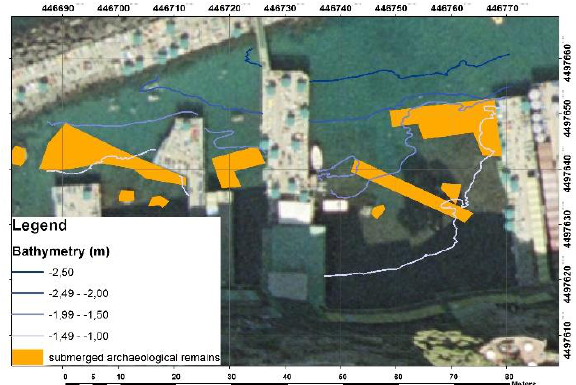
Figure 11. Bathymetric map of the study area (UTM - WGS84